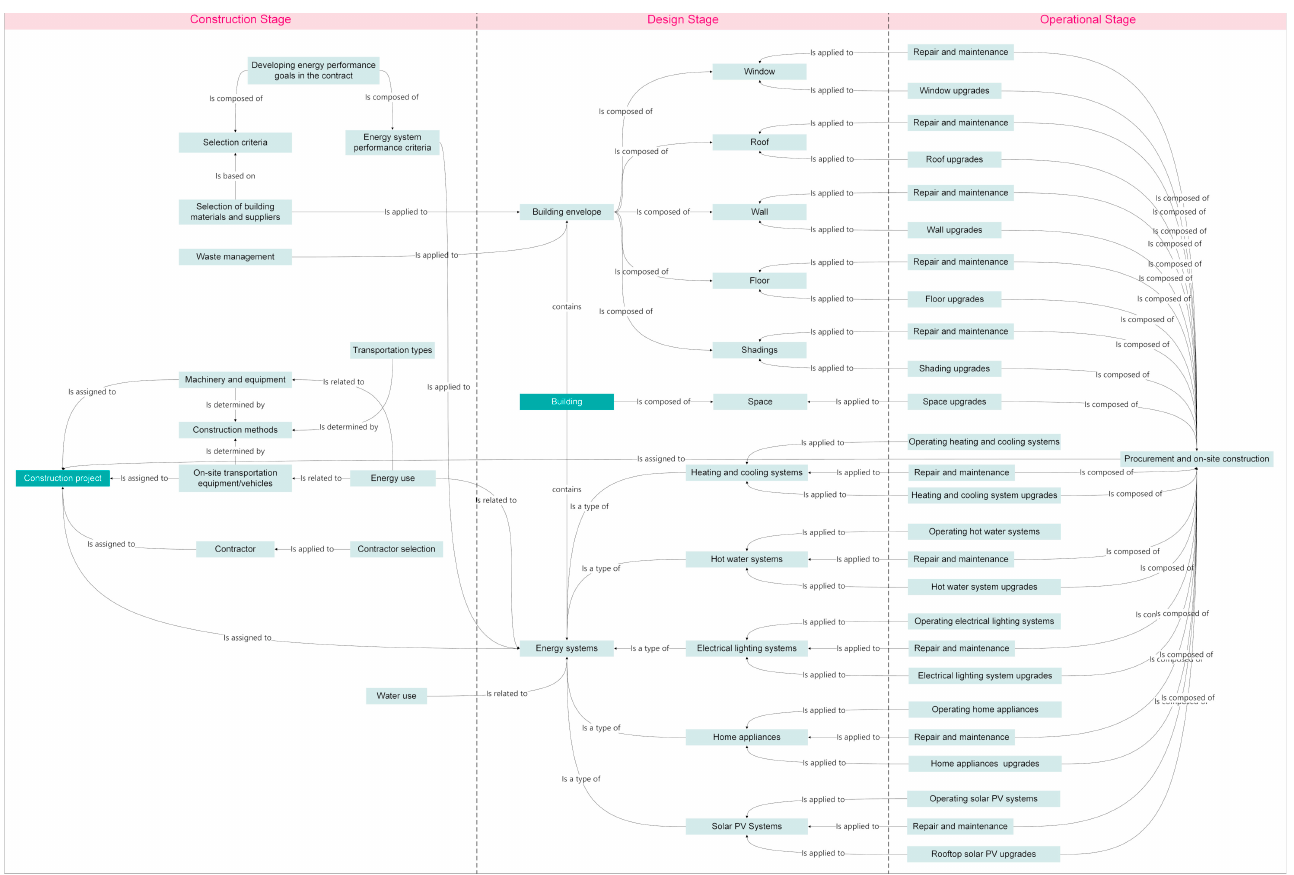
Figure 16. Illustration of examples of connected entities throughout design, construction, and operational stages in the conceptual framework.